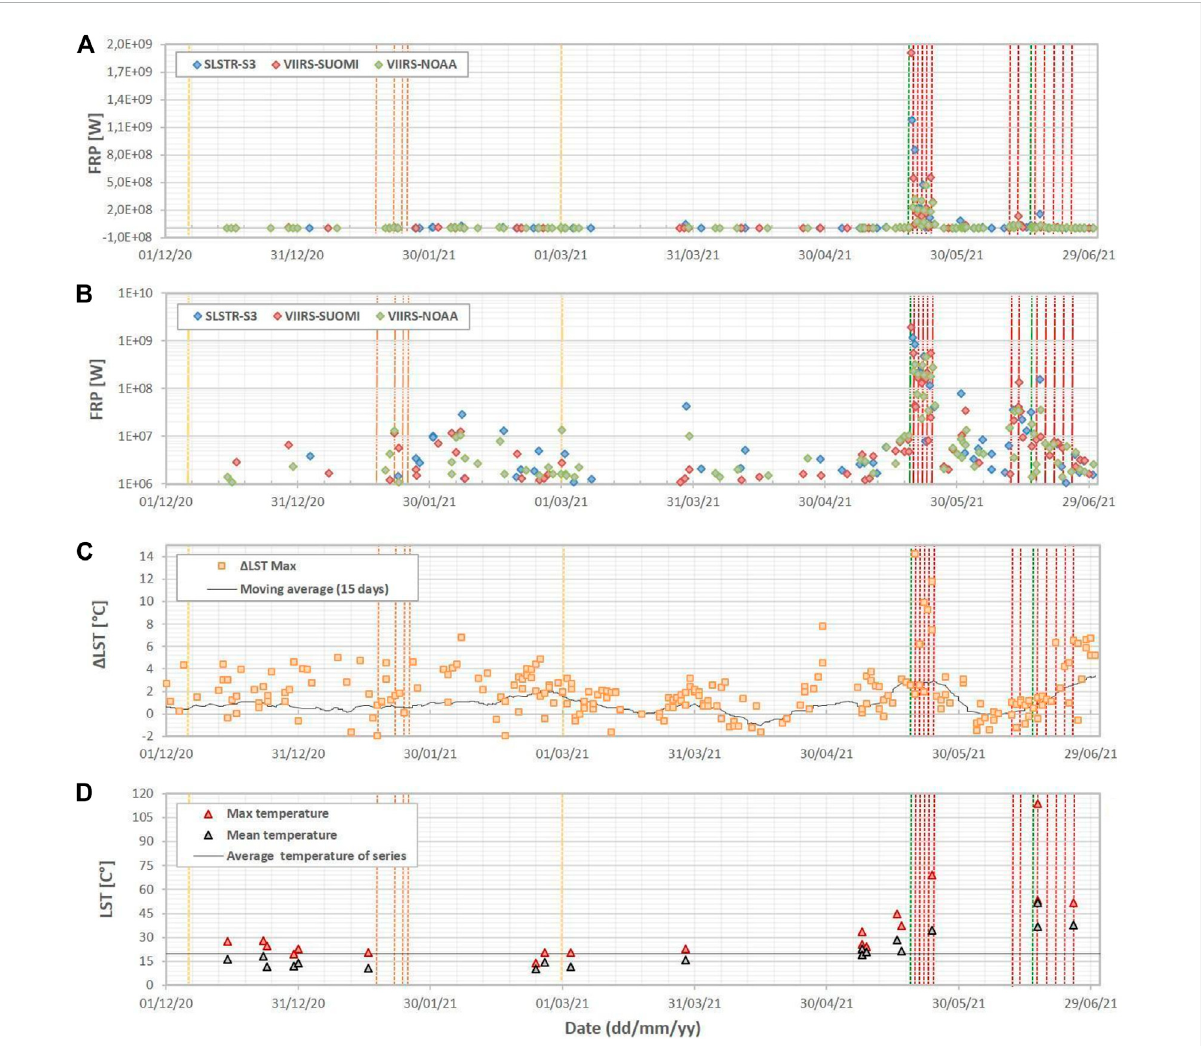
FIGURE 3 Thermal anomalies at Stromboli volcano from 1 December 2020 to 30 June 2021 using SLSTR and VIIRS to estimate FRP (A – B) , MODIS to estimate temperature above average ( Δ LST) (C) , ASTER, L8 and ECOSTRESS to estimate LST at higher spatial resolution (D) . FRP time series retrieved from SLSTR-SENTINEL 3 (blue diamond), VIIRS-SUOMI (red diamond) and VIIRS-NOAA (green diamond) at Stromboli volcano during 1 December 2020 – 30 June 2021 in linear scale (A) and log-scale (B) . (C) Δ T_max retrieved from MODIS for each scene (orange squares) and its 15-days moving average (black line). (D) Temporal series of LST estimations by ASTER, L8 and ECOSTRESS data on summit craters. Mean and maximum temperatures in the considered area are reported; timing of major events are also depicted. The vertical dashed lines show the main phases of eruptiveactivitylistedinTable1:yellow,majorexplosion;orange,spatteringand/orover fl owsfromthesummitvents;red,lava fl owsalongtheSciara del Fuoco; green, failure of the summit cone and pyroclastic density current (PDC) along the Sciara del